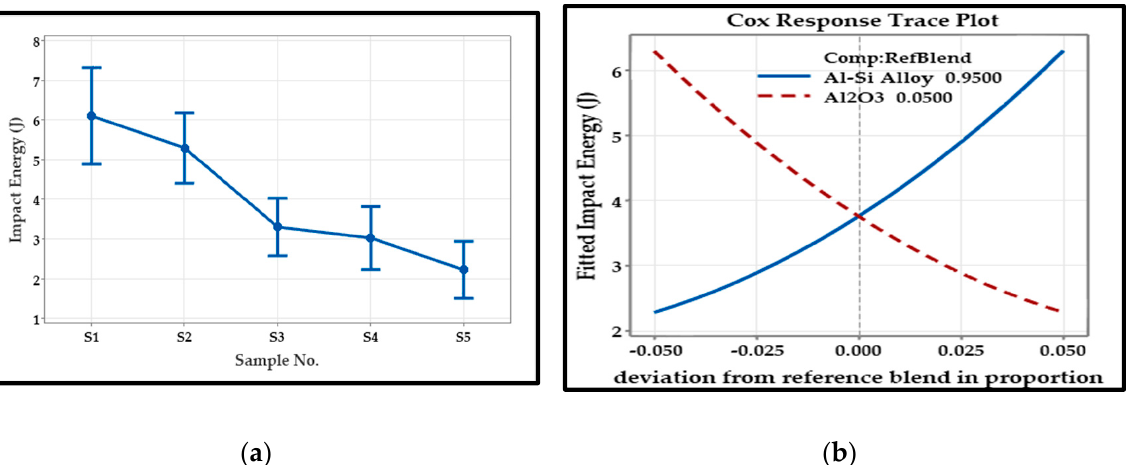
Figure 5. Variation of Impact Energy with reinforcing particles. ( a ) Impact Energy; ( b ) Cox Response Trace